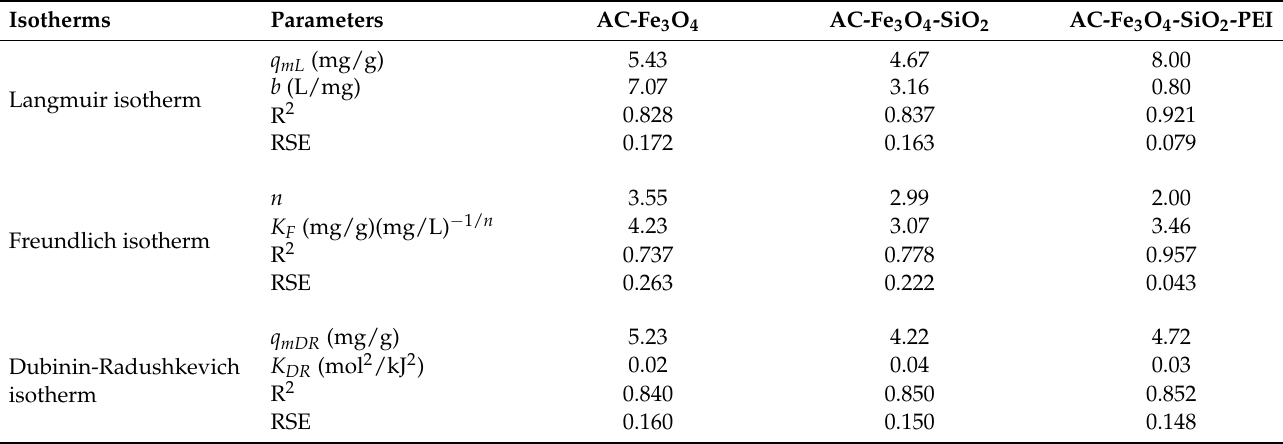
Table 2. The Freundlich and Langmuir adsorption isotherm parameters at 45 ◦ C. Isotherms